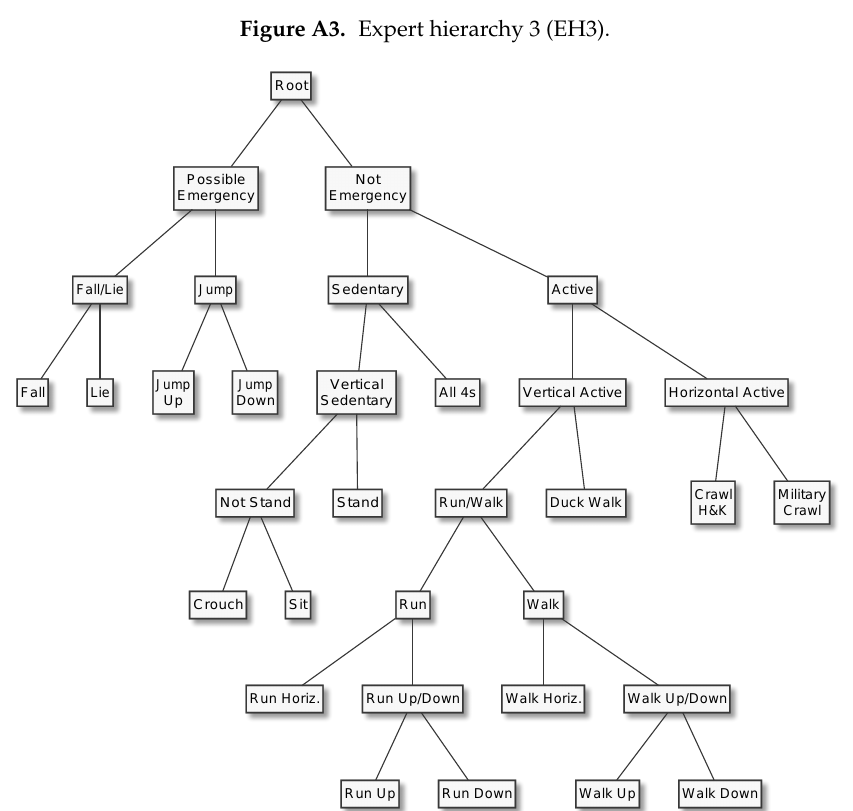
Figure A3. Expert hierarchy 3 (EH3).